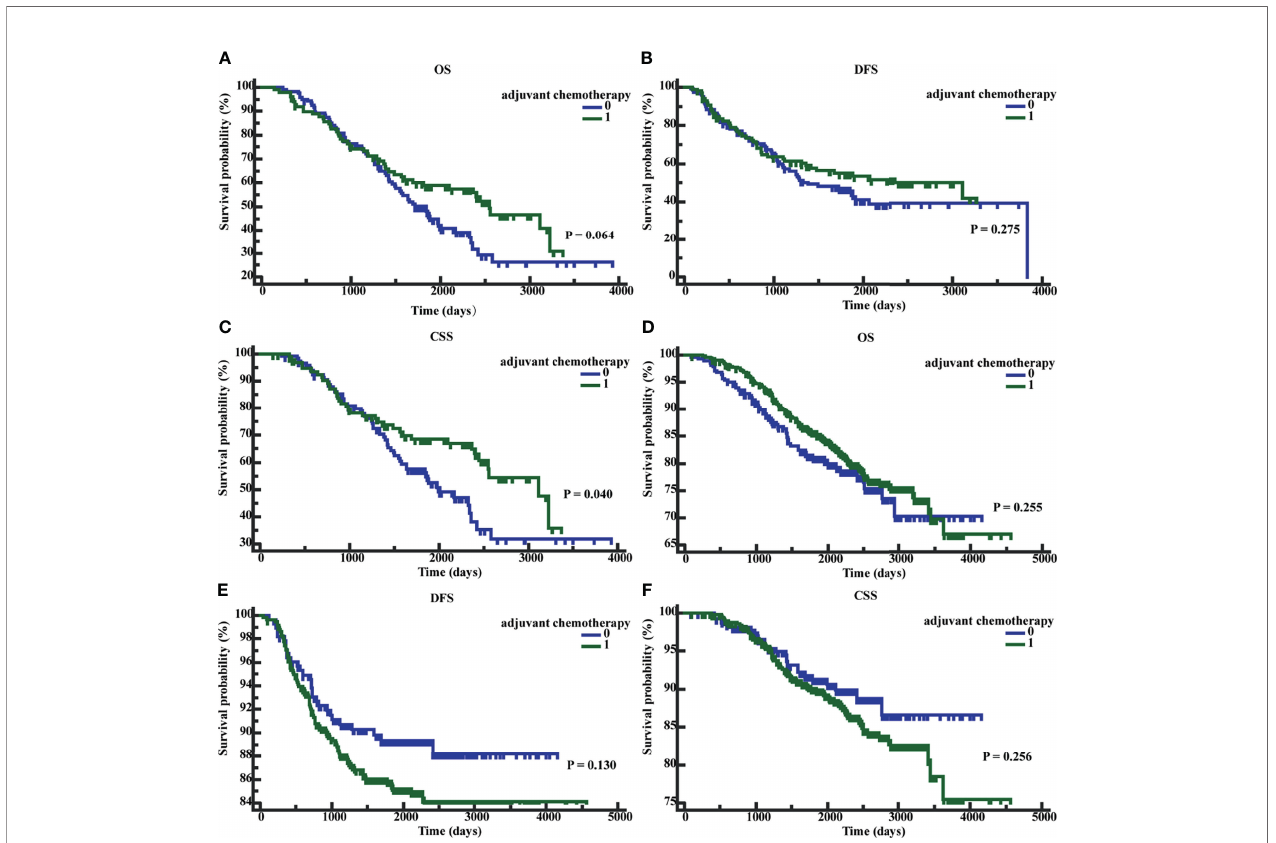
FIGURE 6 | Patients ’ overall survival (OS), disease-free survival time (DFS), and cancer-speci fi c survival (CSS) based on whether receive adjuvant chemotherapy. (A) K-M curves of OS based on whether receive adjuvant chemotherapy in postoperative CEA-positive patients. (B) K-M curves of DFS based on whether receive adjuvant chemotherapy in postoperative CEA -positive patients. (C) K-M curves of CSS based on whether receive adjuvant chemotherapy in postoperative CEA -positive patients. (D) K-M curves of OS based on whether receive adjuvant chemotherapy in postoperative CEA -negative patients. (E) K-M curves of DFS based on whether receive adjuvant chemotherapy in postoperative CEA -negative patients. (F) K-M curves of CSS based on whether receive adjuvant chemotherapy in postoperative CEA -negative patients. 0, without adjuvant chemotherapy; 1, with adjuvant